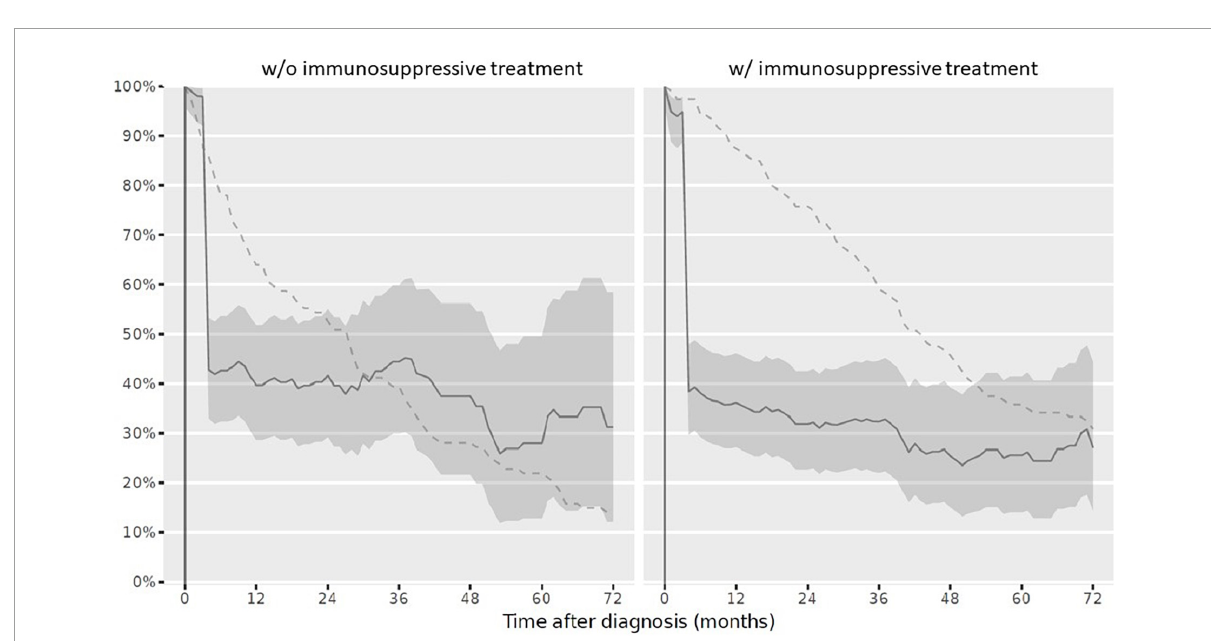
FIGURE6 Complete vaccination status against pneumococcal diseases in children after PRD diagnosis. Legend: y-axis Completeness (% patients vaccinated completely, solid line with 95% confidence interval); x-axis Sample size (% patients available, dashed line). PRD pediatric patients with rheumatic disease. w/o, without immunosuppressive treatment, w/ with immunosuppressive